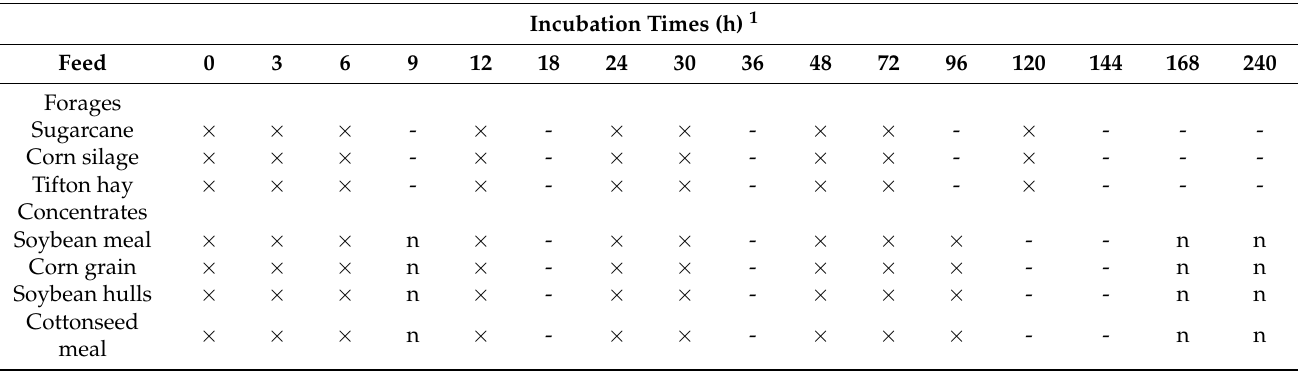
Table 5. Description of selected incubation times to establish minimum designs of sampling times for in situ degradation studies of forage and concentrate dry